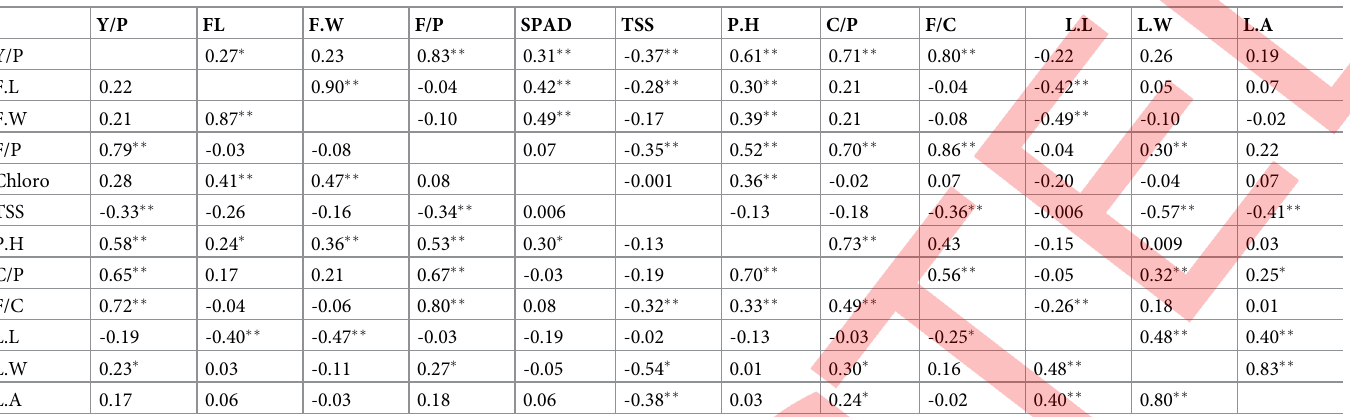
plant’s height (0.30), but it had a negative correlation with the leaf length (-0.42). Leaf length, SPAD values and height of the plants had moderate negative (-0.42), moderately positive (0.49) and weak positive correlation (0.39) with the width of fruit, respectively. Plant height was found to be highly positively correlated with the number of clusters/plant (0.73). The clus- ters/plant had a moderate positive correlation with the number of fruits/ cluster (0.55) (Table 4). It is a general phenomenon that higher heritability results in higher genetic gains in subse- quent generations. In our current experiment, the broad-sense heritability was found to be high for all observed traits (Table 5). Leaf length had the highest heritability among all other